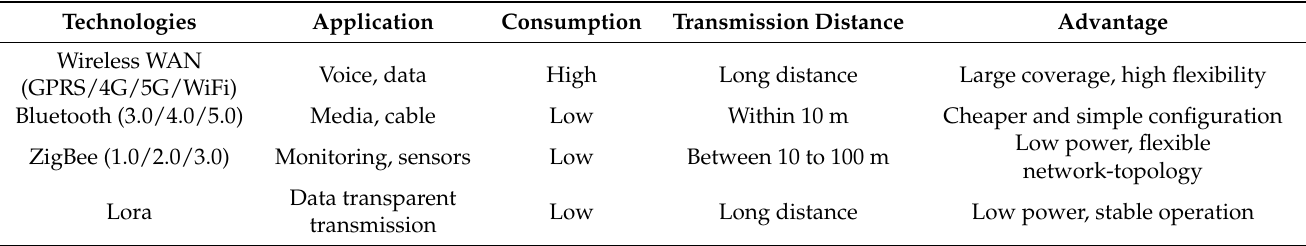
Table 3. Communication technologies of agricultural